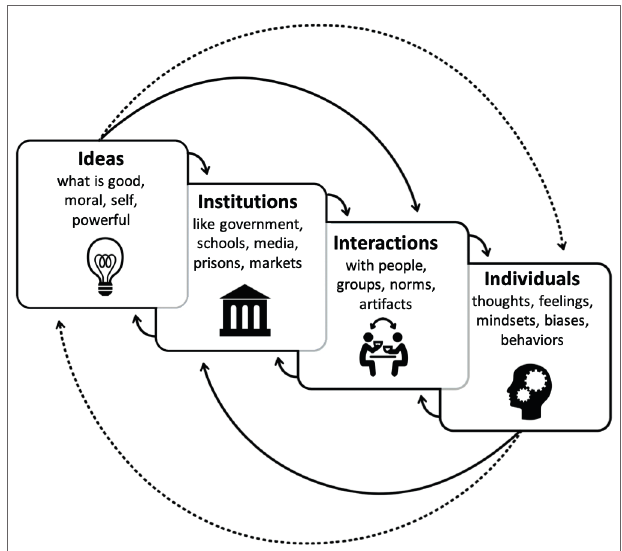
FIGURE 1 | The culture cycle. Adapted from Fiske et al. (1998), Markus and Conner (2014), and Markus and Kitayama